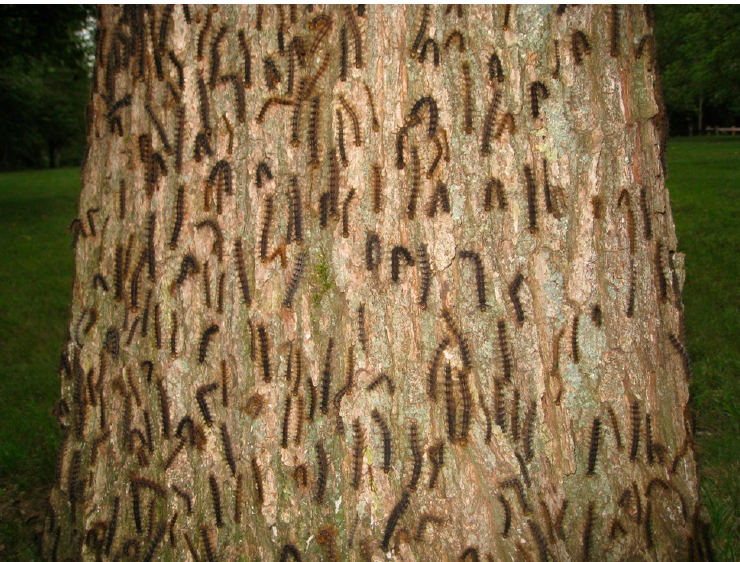
Figure 2. Epizootic in a gypsy moth, Lymantria dispar , population, principally caused by Entomophaga maimaiga . The majority of these cadavers are filled with E. maimaiga resting spores (azygospores), although some could have died from Lymantria dispar multiple nucleopolyhedrovirus or co-infections of these two pathogens (photo by Heather Faubert).